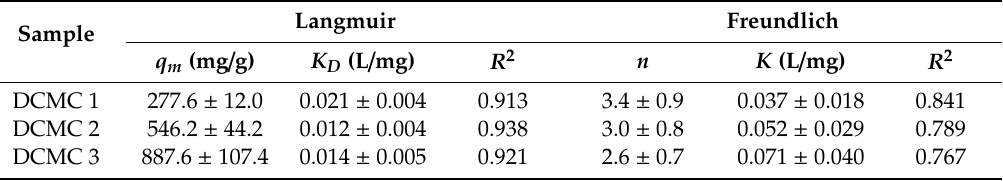
Figure 6. Adsorption isotherms at pH = 3: ( a ) DCMC 1, ( b ) DCMC 2, and ( c ) DCMC 3.